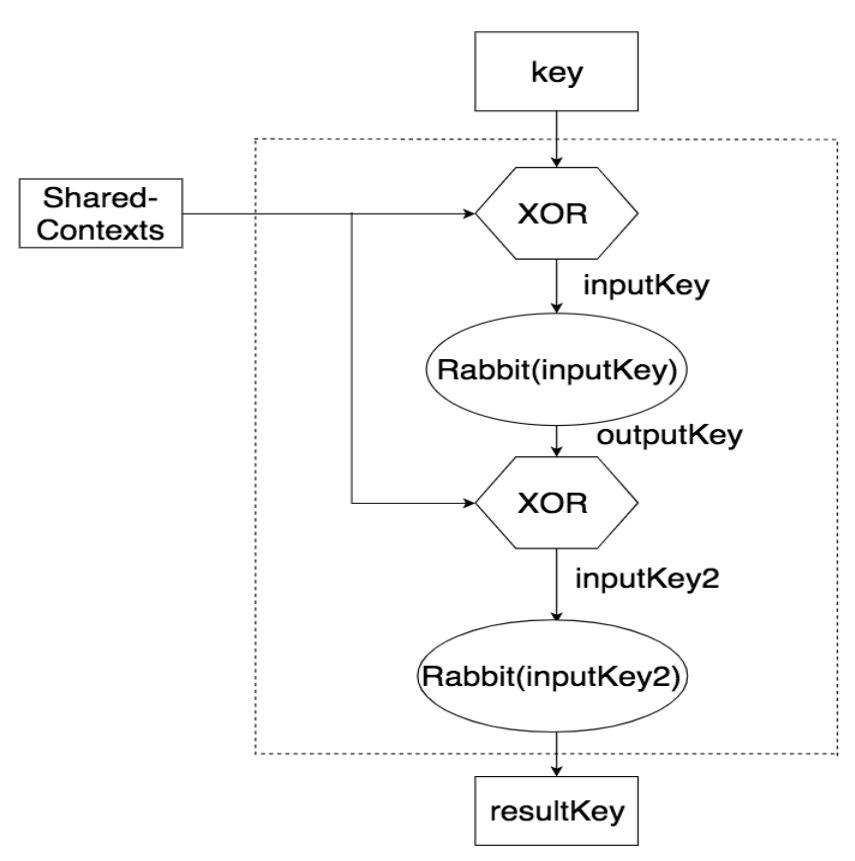
Figure 5. The proposed Modified Rabbit